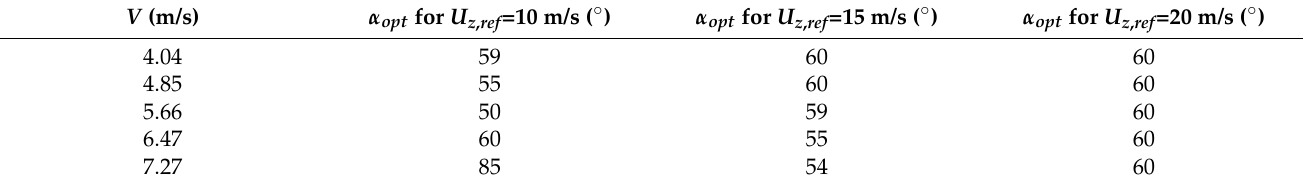
Table 3. The optimal angles of attack obtained for the different ship and wind speeds considered. α opt for U z , ref =10 m/s ( ◦ )